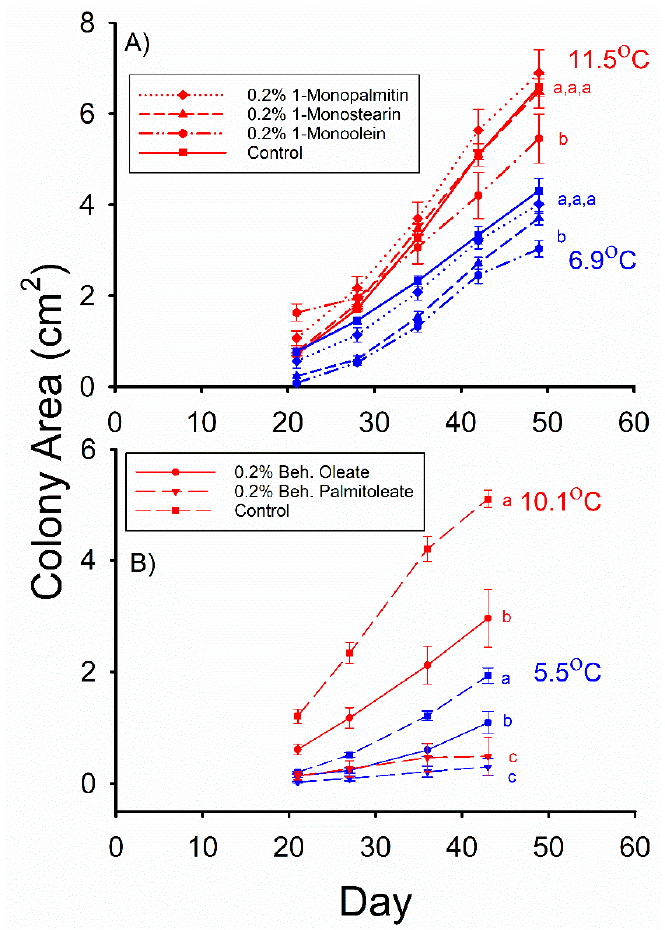
Figure 2. Mean (± SE) surface areas of Pseudogymnoascus destructans colonies at various stages of growth in: ( A ) Experiment 3, and, ( B ) Experiment 4 at T a = 5.5–6.4 (blue symbols) and 10.1–11.5 °C (red symbols). Means within the same T a treatment and experiment sharing a common lower-case letter are not significantly different at the p < 0.05 level.